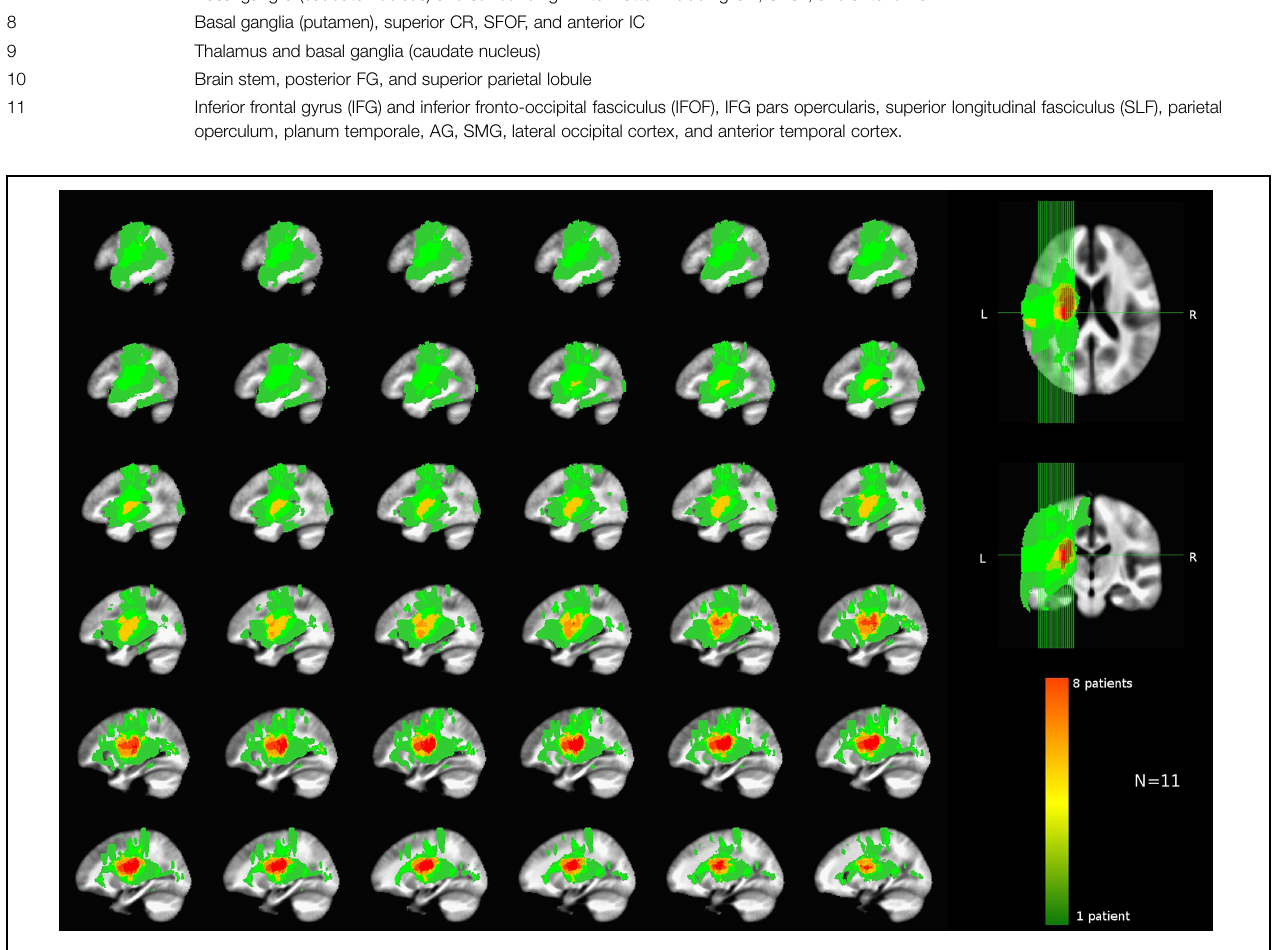
Frontiers in Human Neuroscience |